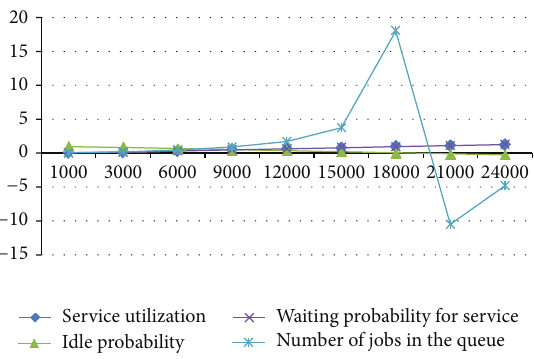
Figure 6: Experimental results by increasing service rates 1.